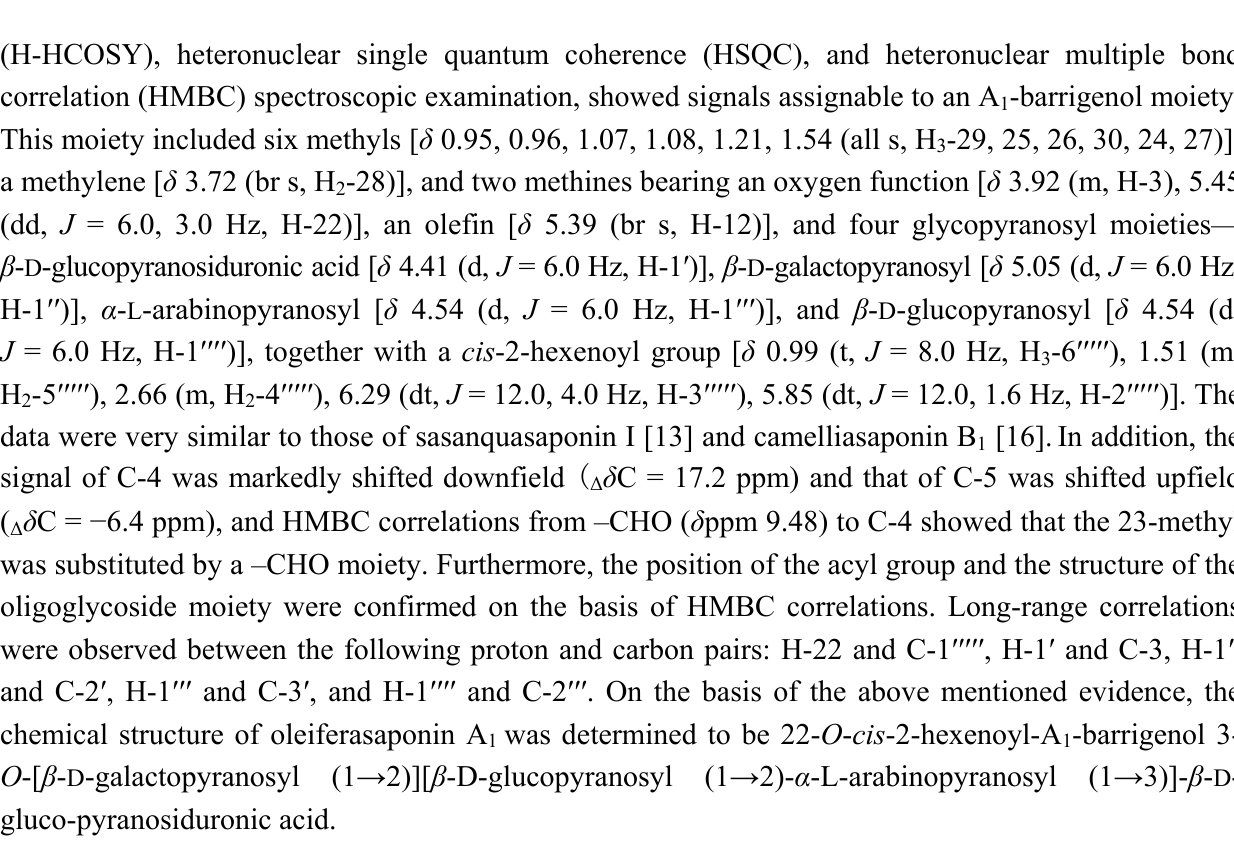
Figure 1. 2D NMR correlations and MS/MS fragmentation of oleiferasaponin A